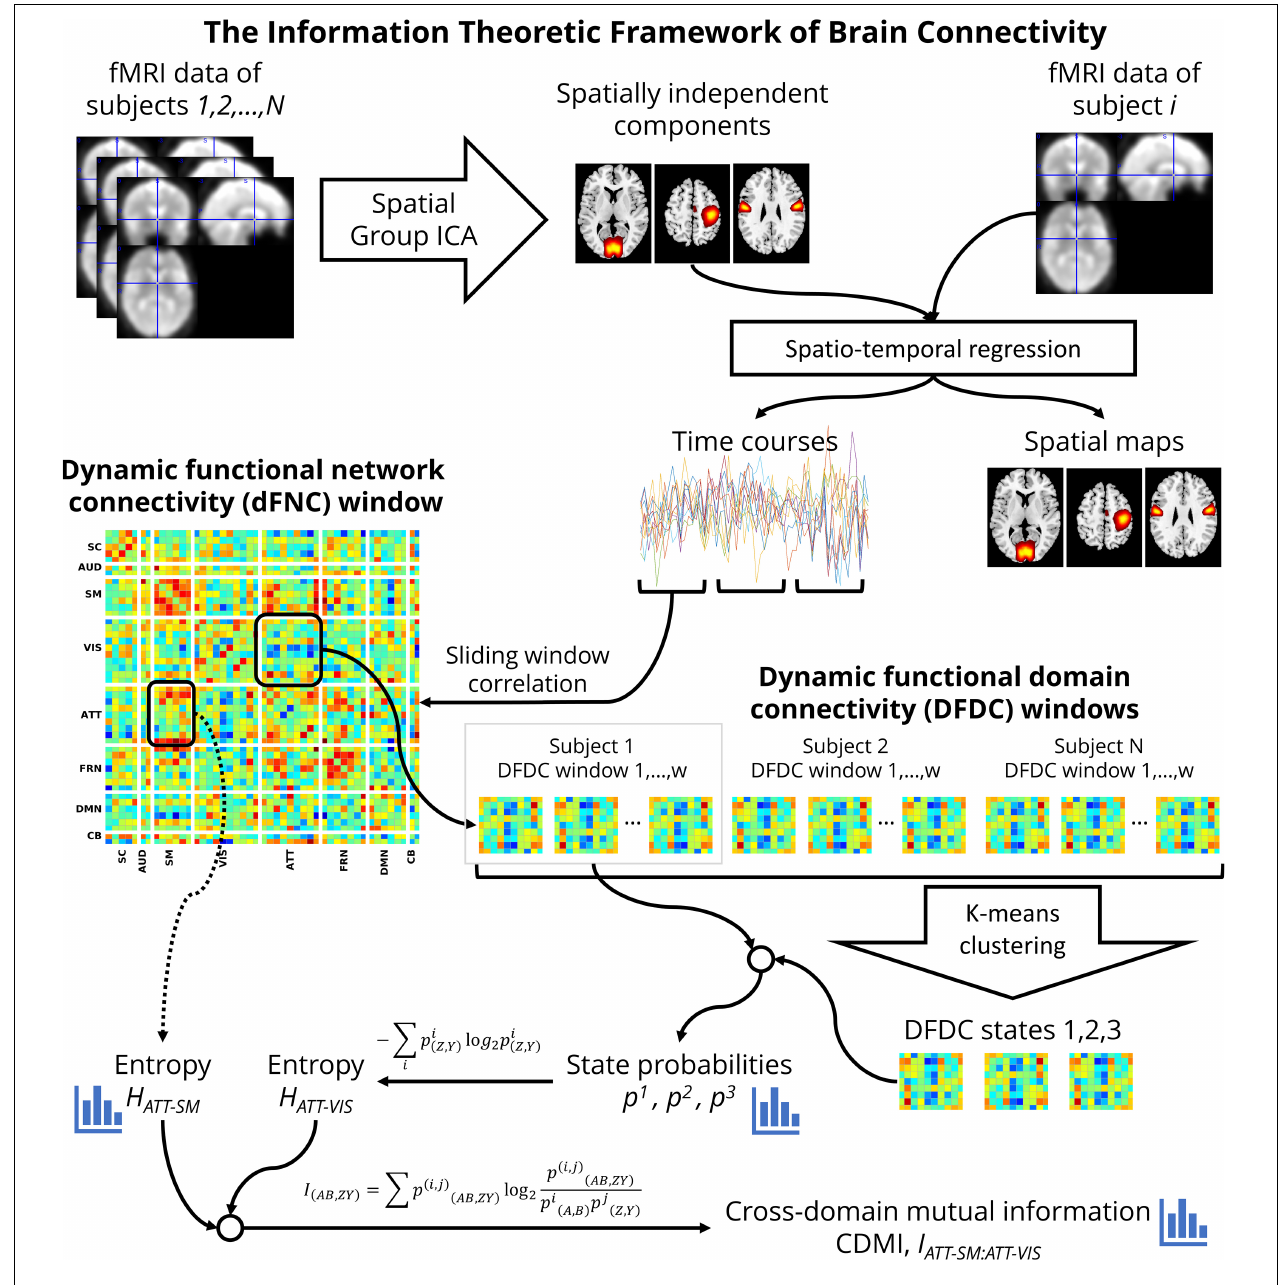
FIGURE 1 | A flowchart of the information theoretic framework of